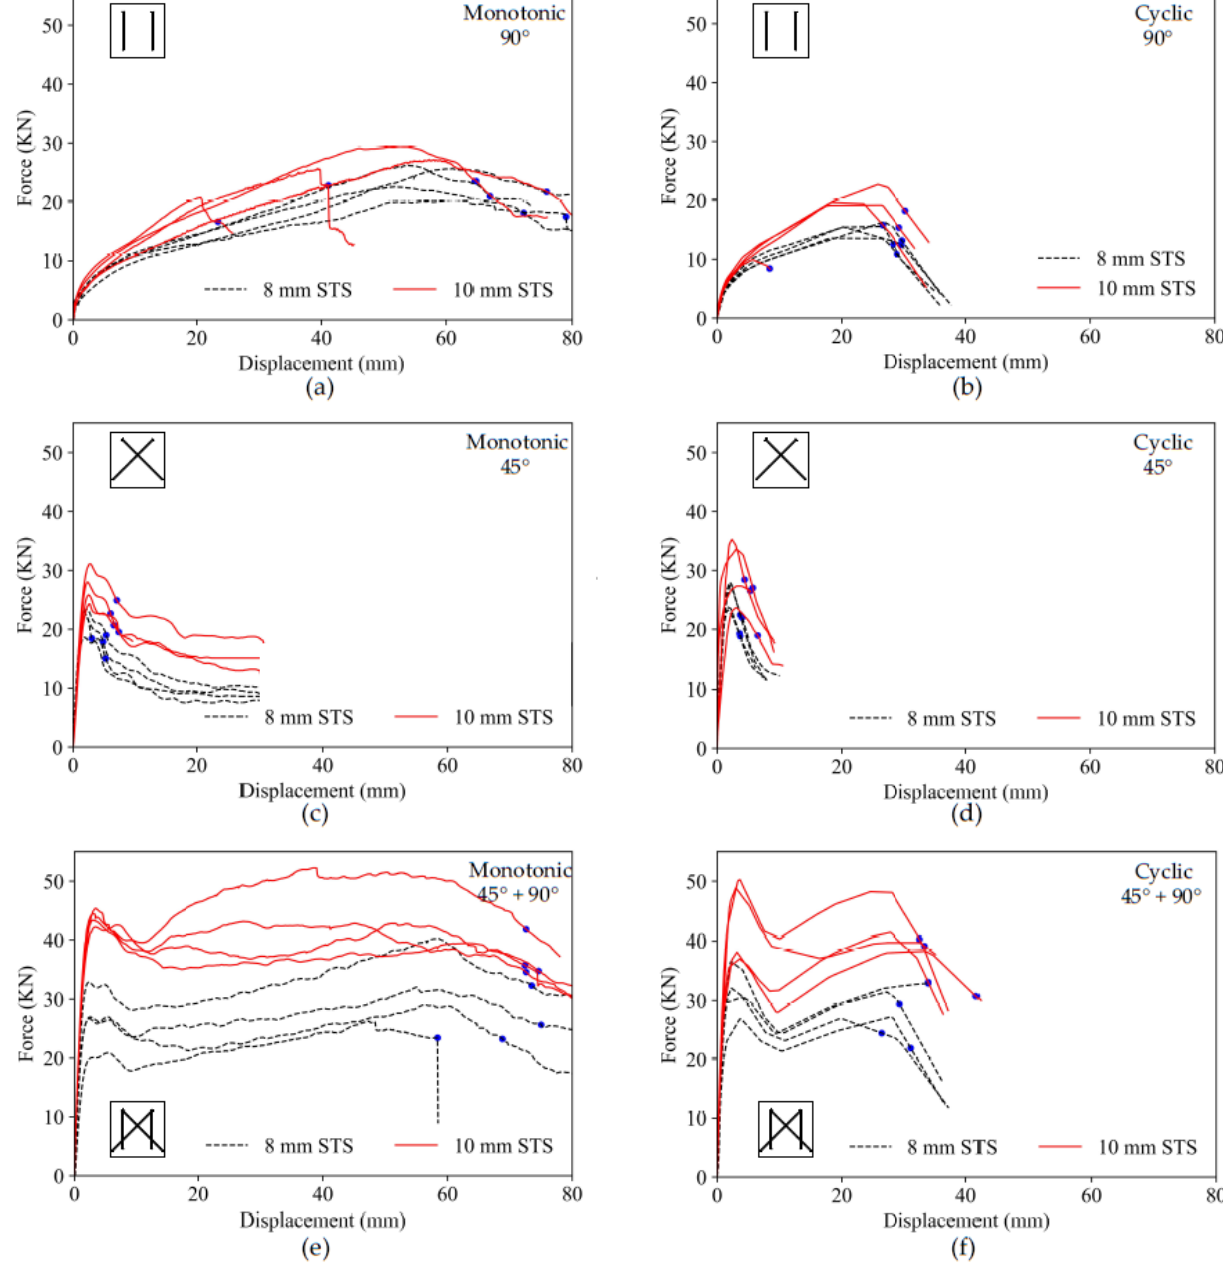
Figure 4. Cyclic backbones and monotonic curves of STS connections: ( a ) 90 ◦ STS under monotonic; ( b ) 90 ◦ STS under cyclic; ( c ) 45 ◦ STS under monotonic; ( d ) 45 ◦ STS under cyclic; ( e ) mixed angle (45 ◦ and 90 ◦ ) STS under monotonic; ( f ) mixed angle (45 ◦ and 90 ◦ ) STS under cyclic. Notes: Failure points are marked with dots at 80% of maximum load on the descending phase.